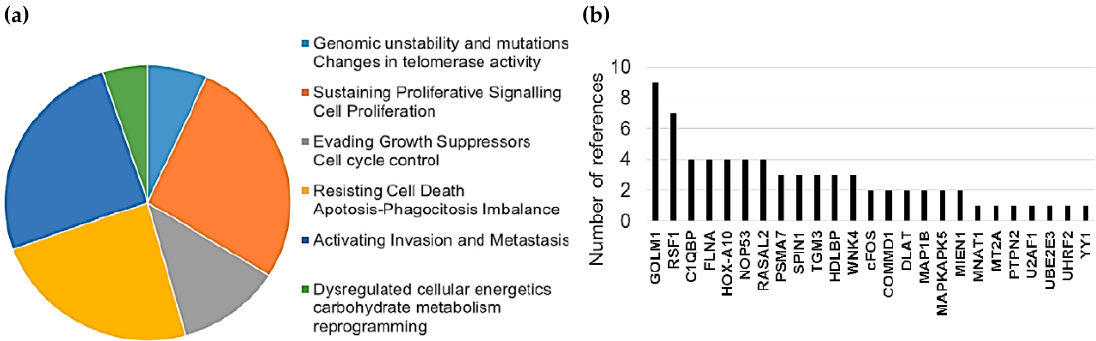
Figure 1. Relationship between identified proteins and cancer hallmarks: ( a ) Distribution of HMGB1 and HMGB2 interactome targets according to cancer hallmarks and ( b ) number of references that associate these proteins with cancer hallmarks according to PubMed (7-31-2019).